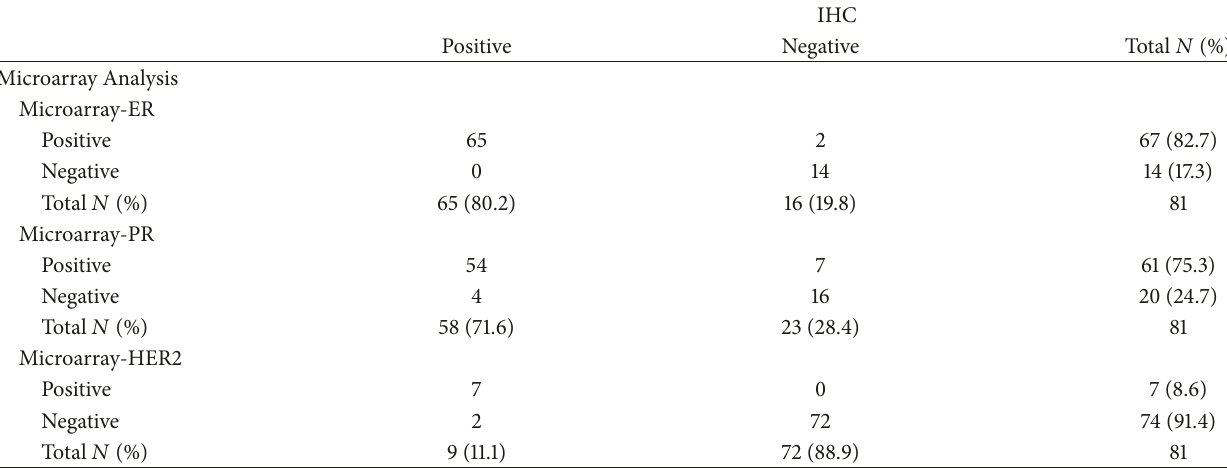
Table 2: Microarray gene expression Values of ER, PR, and HER2 compared to Immunohistochemistry.